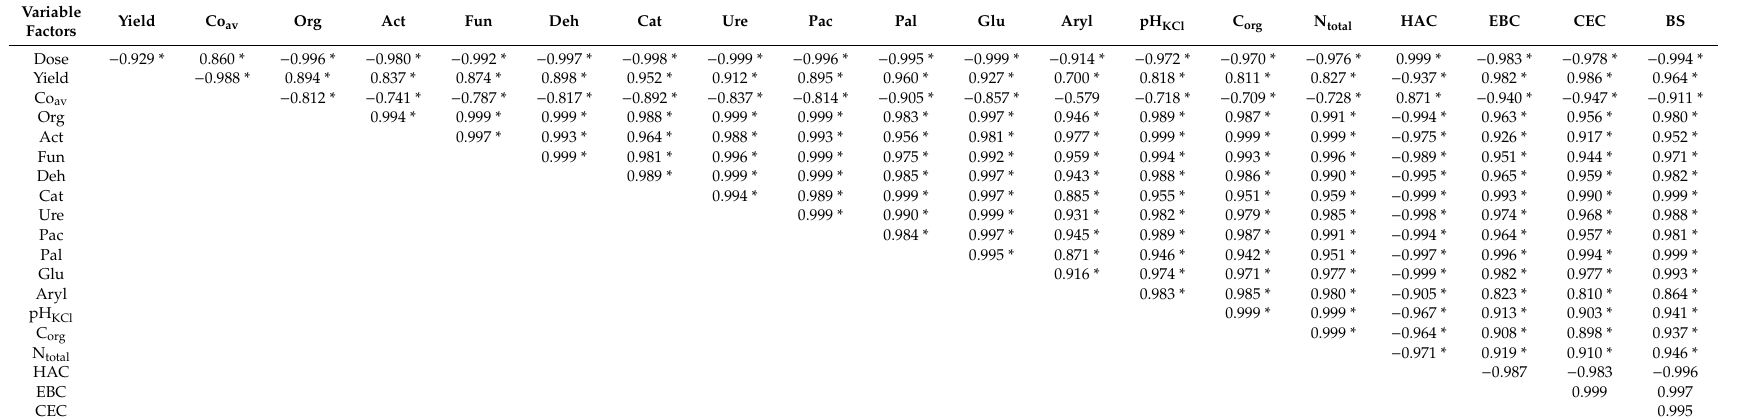
Table 18. Coe ffi cients of correlation between variables in treatments sown with loamy